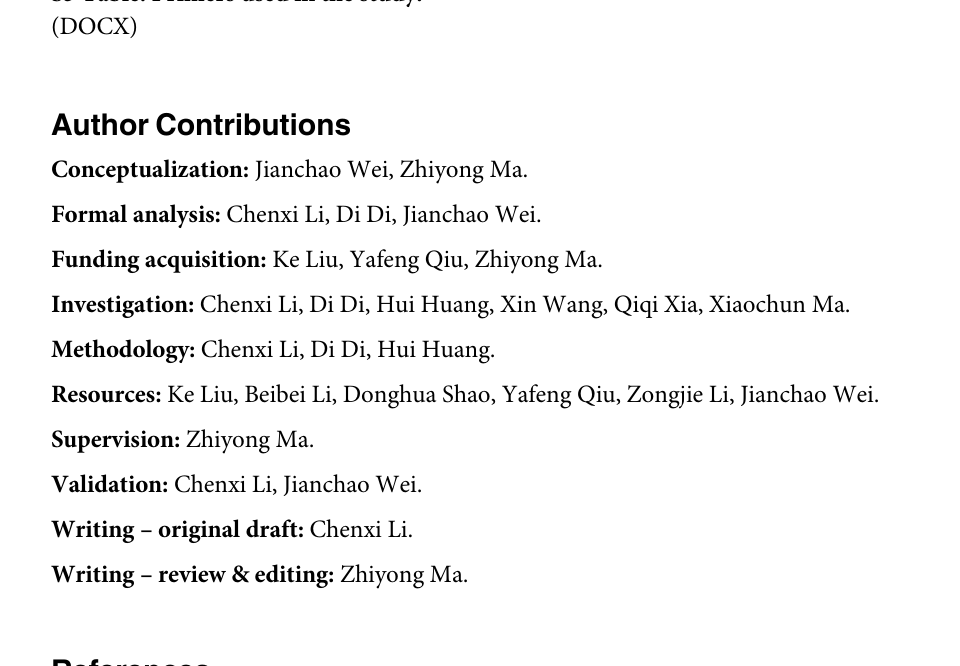
S3 Table. Primers used in the